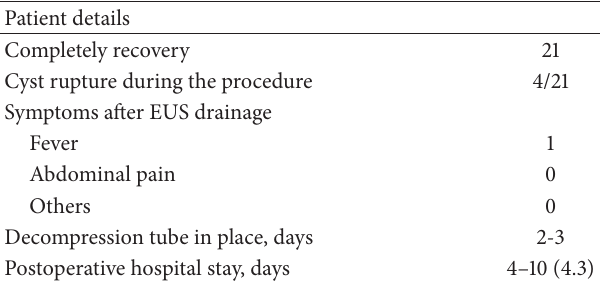
Table 2: Patients results of EUS-guided